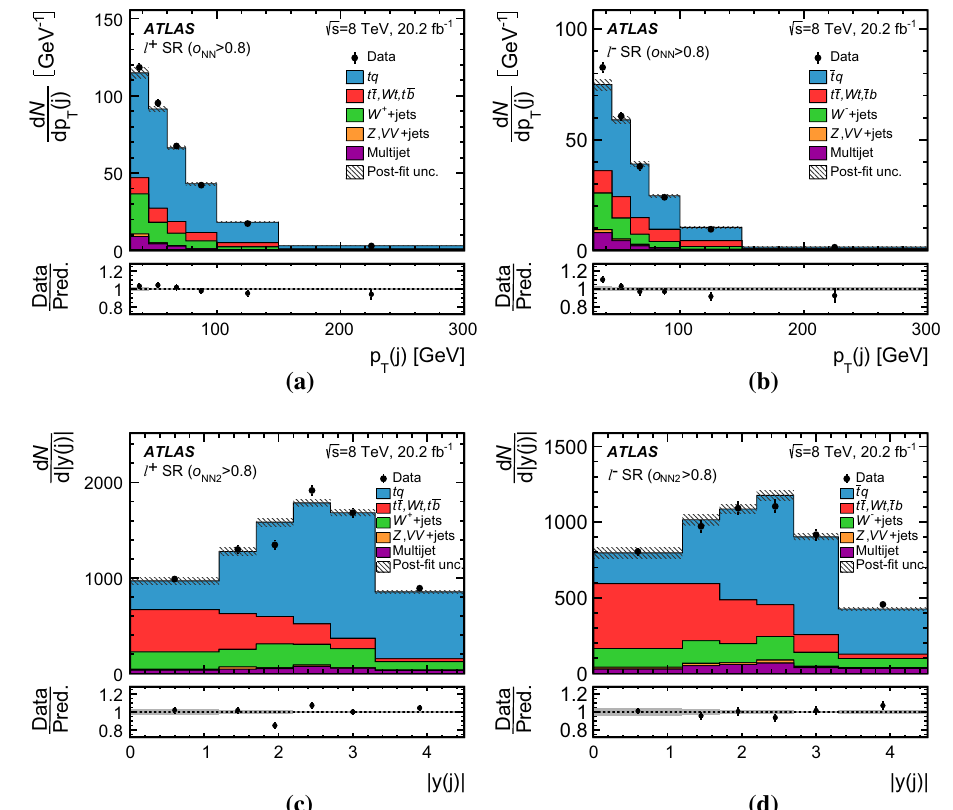
Fig. 15 Measured distributions of ( a , b ) p T ( j ) and ( c , d ) | y ( j ) | at reconstruction level for ( a , c ) (cid:5) + and ( b , d ) (cid:5) − events in the signal region (SR) after a cut of O NN ( O NN2 ) > 0 . 8 The distributions are compared to the model obtained from simulated events. The simulated distributions are normalised to the event rates obtained by the fit to the